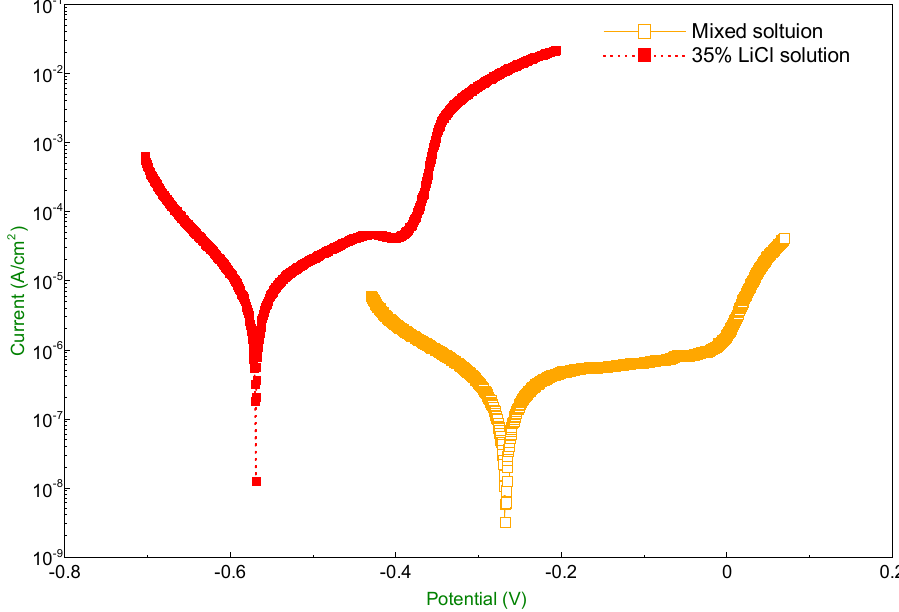
Figure 1. Polarization curves for stainless steel in different solutions.